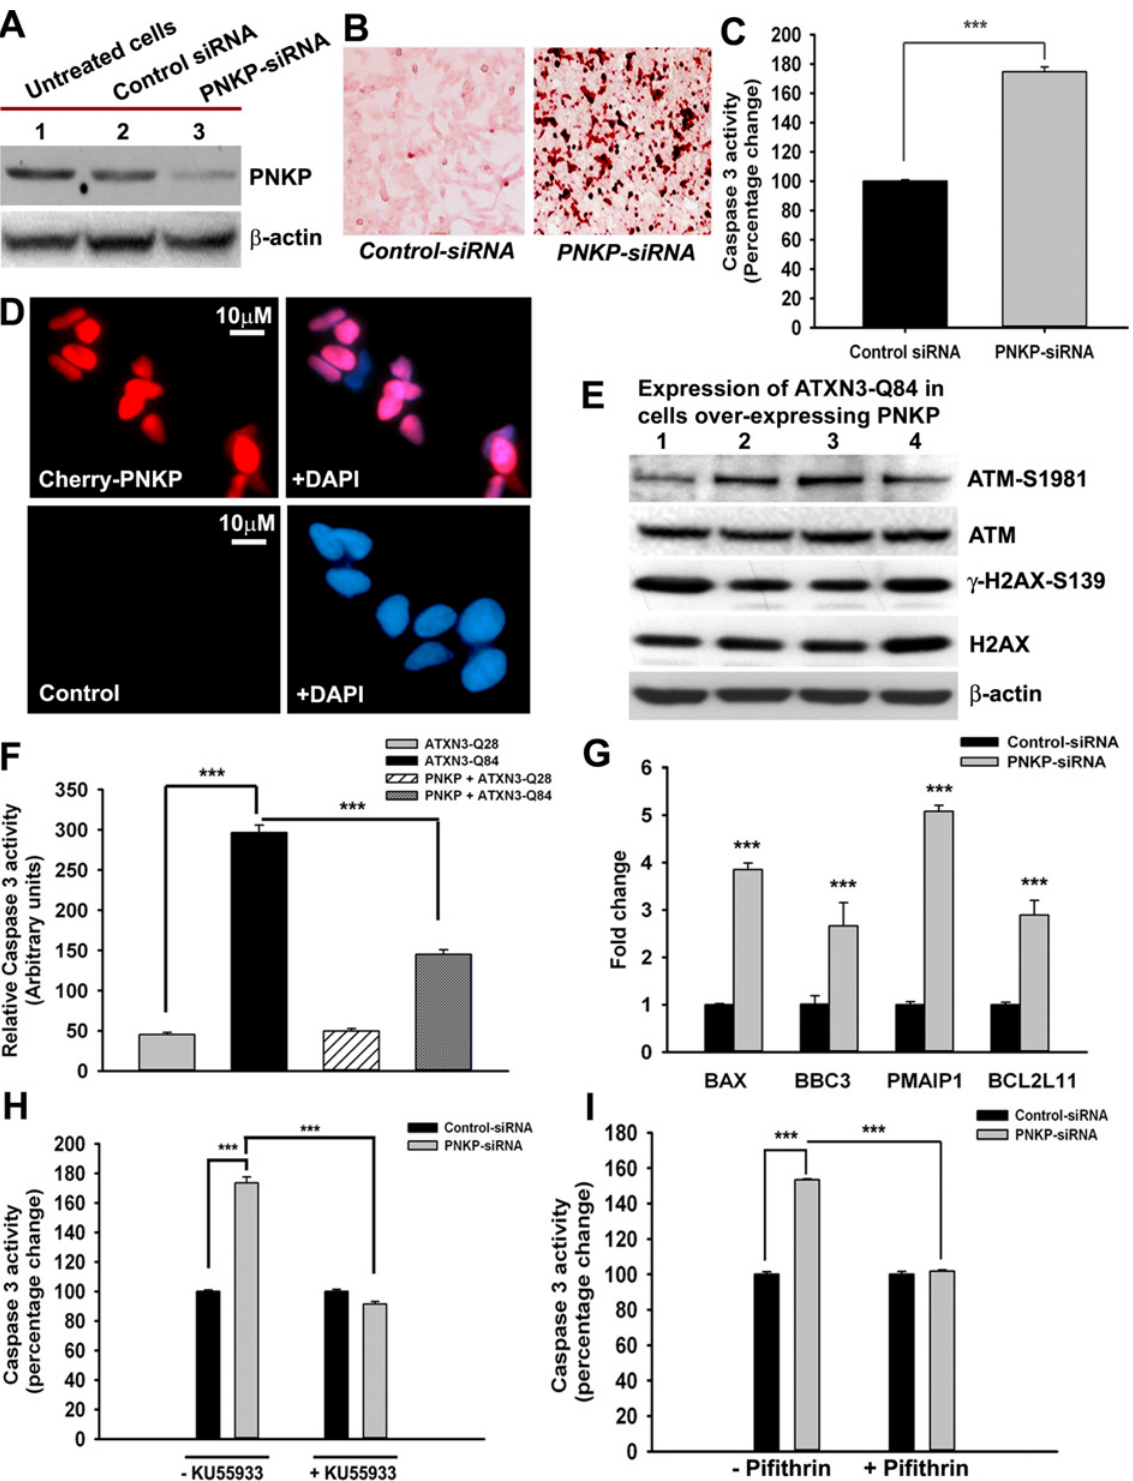
Figure 5. The mutant ATXN3-induced apoptotic pathway is rescued by PNKP-overexpression or inhibition of ATM and p53. (A) Total protein was isolated from control untreated SH-SY5Y cells (lane 1), SH-SY5Y cells transfected with control-siRNA (lane 2) and SH-SY5Y cells transfected with PNKP- siRNA (lane 3), the cells harvested 48 hours after transfection, and their lysates analyzed by Western blotting to determine the PNKP levels; β -actin was used as the loading control. (B) Light microscopic images showing TUNEL staining of SH-SY5Y cells transfected with control-siRNA or PNKP-siRNA .